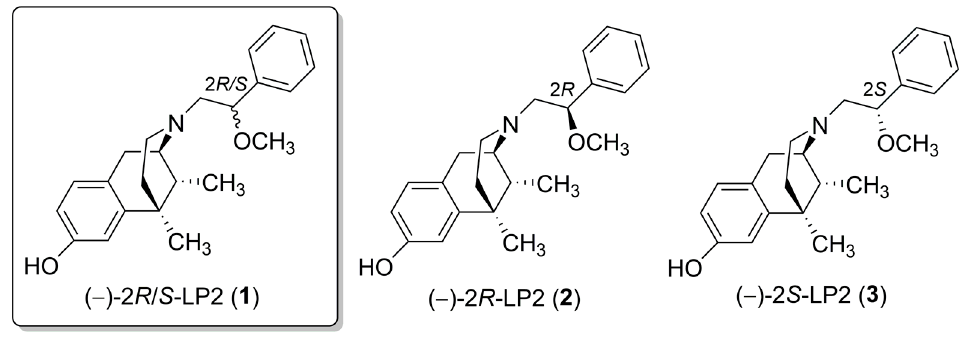
Figure 1. ( − )-LP2 isomers structures.